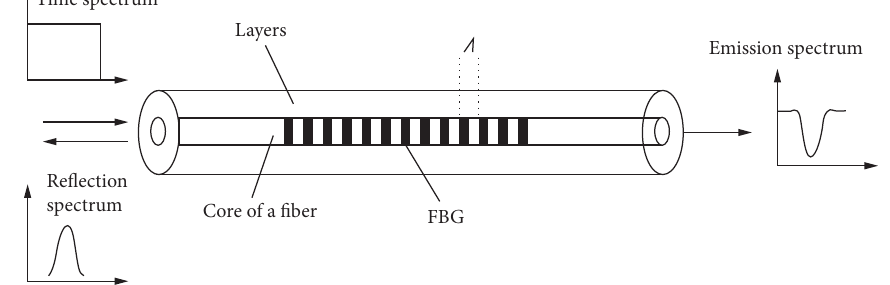
Figure 1: Sensing principle of